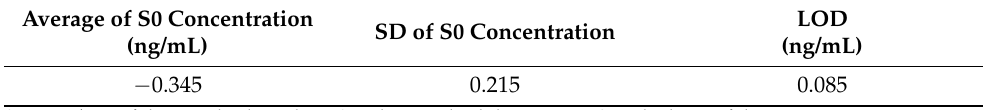
Figure 5. The sandwich ELISA method for PAT/pat detection. ( a ) Standard curve of the Pat/pat ELISA. ( b ) Linear detection range from the standard curve in ( a ). Table 3. LOD of the developed PAT/pat ELISA method. Average of S0 Concentration